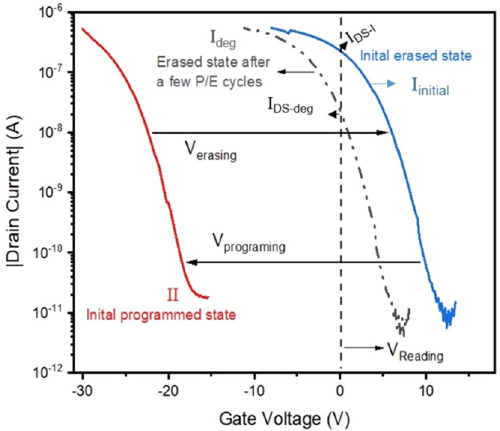
Figure 1. Schematic drawing of the degraded transfer characteristics for the OFET.